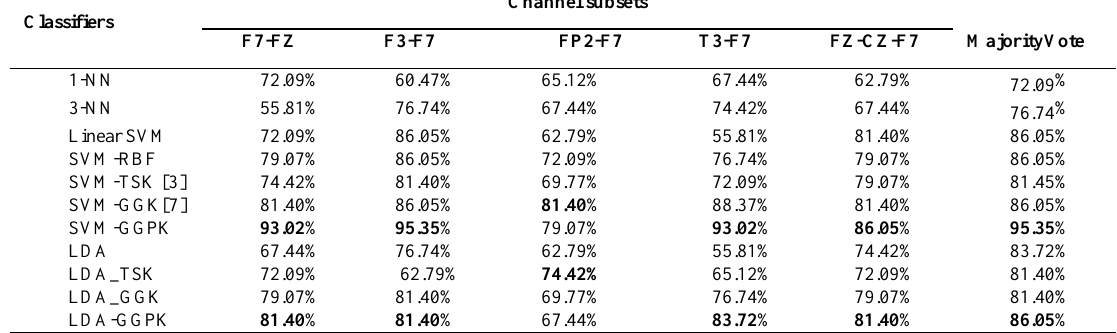
Table 1. Accuracy of different classifiers (1-NN, 3-NN, linear SVM, SVM with RBF, TSK, GGPK, and GGK kernels) on different subsets of EEG signals of ADHD and BMD patients at eyes-open resting condition. Channel subsets